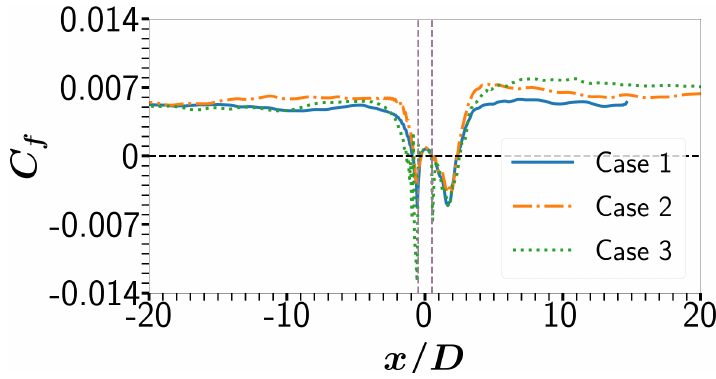
Figure 9. Streamwise variation of C f for Case 1, Case 2 and Case 3.